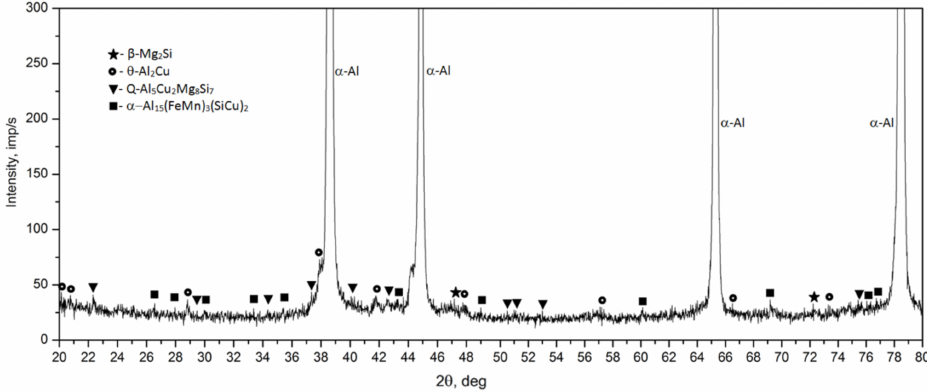
Figure 10. X-ray diffraction pattern of the 2017A alloy after solution heat treatment. Measurement of the hardness of samples from the 2017A alloy that differ in the value of the solution heat treatment temperature showed that the hardness of the alloy increases with the increase in solution heat treatment temperature (Figure 11). The sample solution heat treated from 490 ◦ C is characterized by the lowest hardness value, i.e., 81.5 HB, while the sample solution heat treated from 510 ◦ C is the highest, i.e., 91.6 HB (Figure 11). The highest hardness of the alloy after solution heat treatment at the highest temperature, i.e., 510 ◦ C, results from the almost complete dissolution of intermetallic phases in the solid solution (Figure 9b), which causes homogenization and strengthening of the solution heat treated alloy.